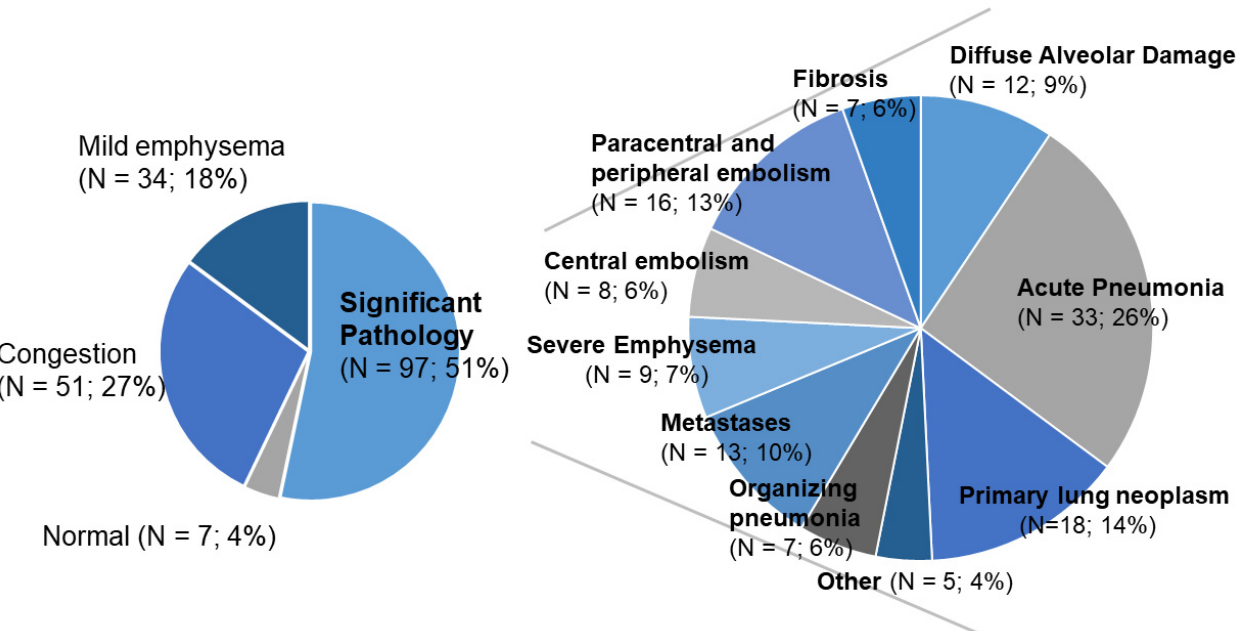
Figure 2. Overview of pulmonary pathologies found in consecutive adult autopsies from a 2-year period (2016–2017). A total of 197/189 patients showed significant pulmonary pathologies at postmortem examination (left side). A total of 28 patients had more than one pulmonary pathologic finding, leaving a total of 128 significant pulmonary diagnoses (right side).